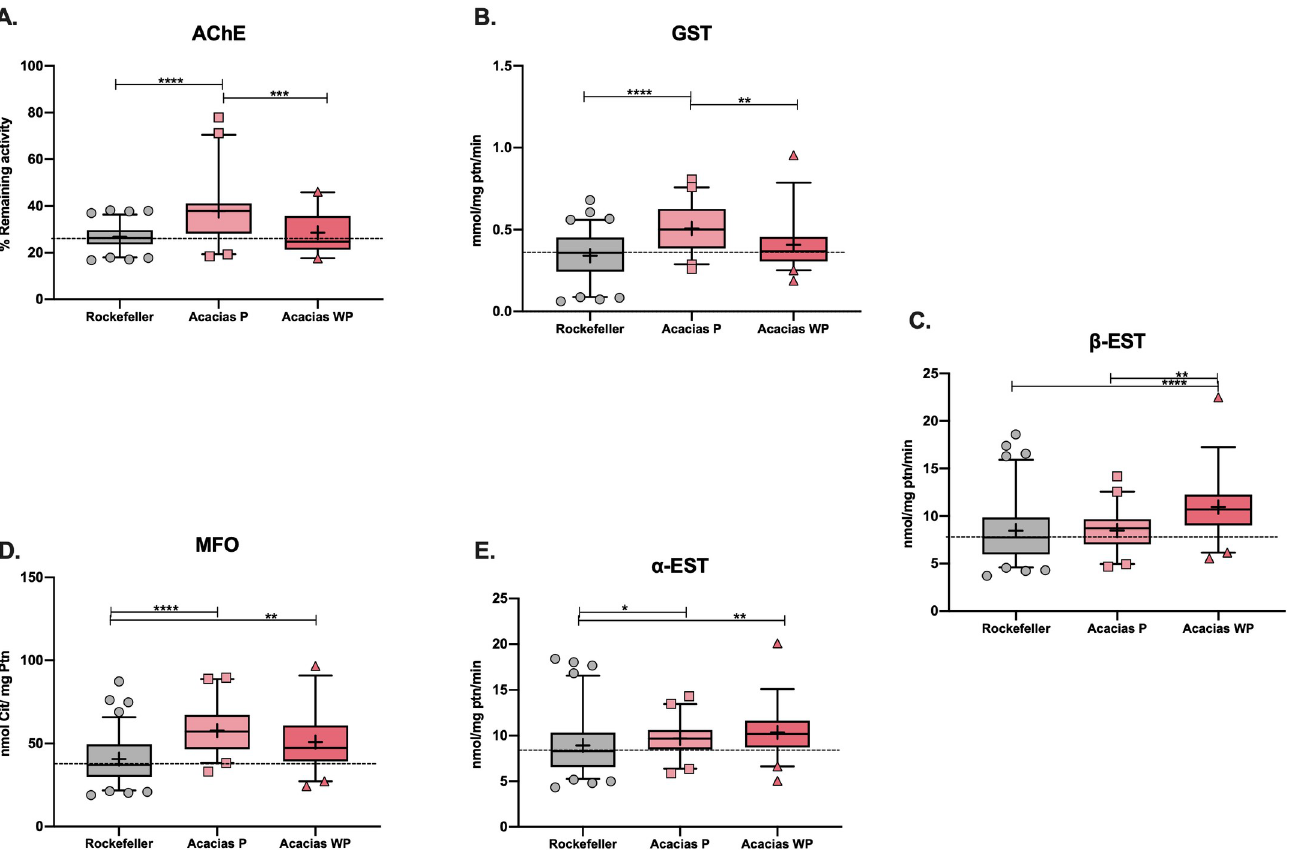
Fig 7. Enzyme activity for Aedes aegypti collected from Acacı´as with lambda-cyhalothrin pressure in the lab (Acacı´as P) and without pressure (Acacı´as WP). A) Acetylcholinesterase (AChE), B) glutathione-S-transferases (GST), C) β -esterases ( β -EST) D) mixed-function oxidases (MFO) and E) α -esterases, ( α -EST). Forty individuals were used in each assay. Box plots include the mean (+), median (line), 5th, 25th, 75th, and 95th percentiles. The dotted line corresponds to the median activity for the susceptible strain (Rockefeller). Asterisks indicate significant differences between the Rockefeller strain and the corresponding population (Kruskal- Wallis test; ���� = p < 0.0001, ��� = p < 0.001, �� = p < 0.01, � = p <